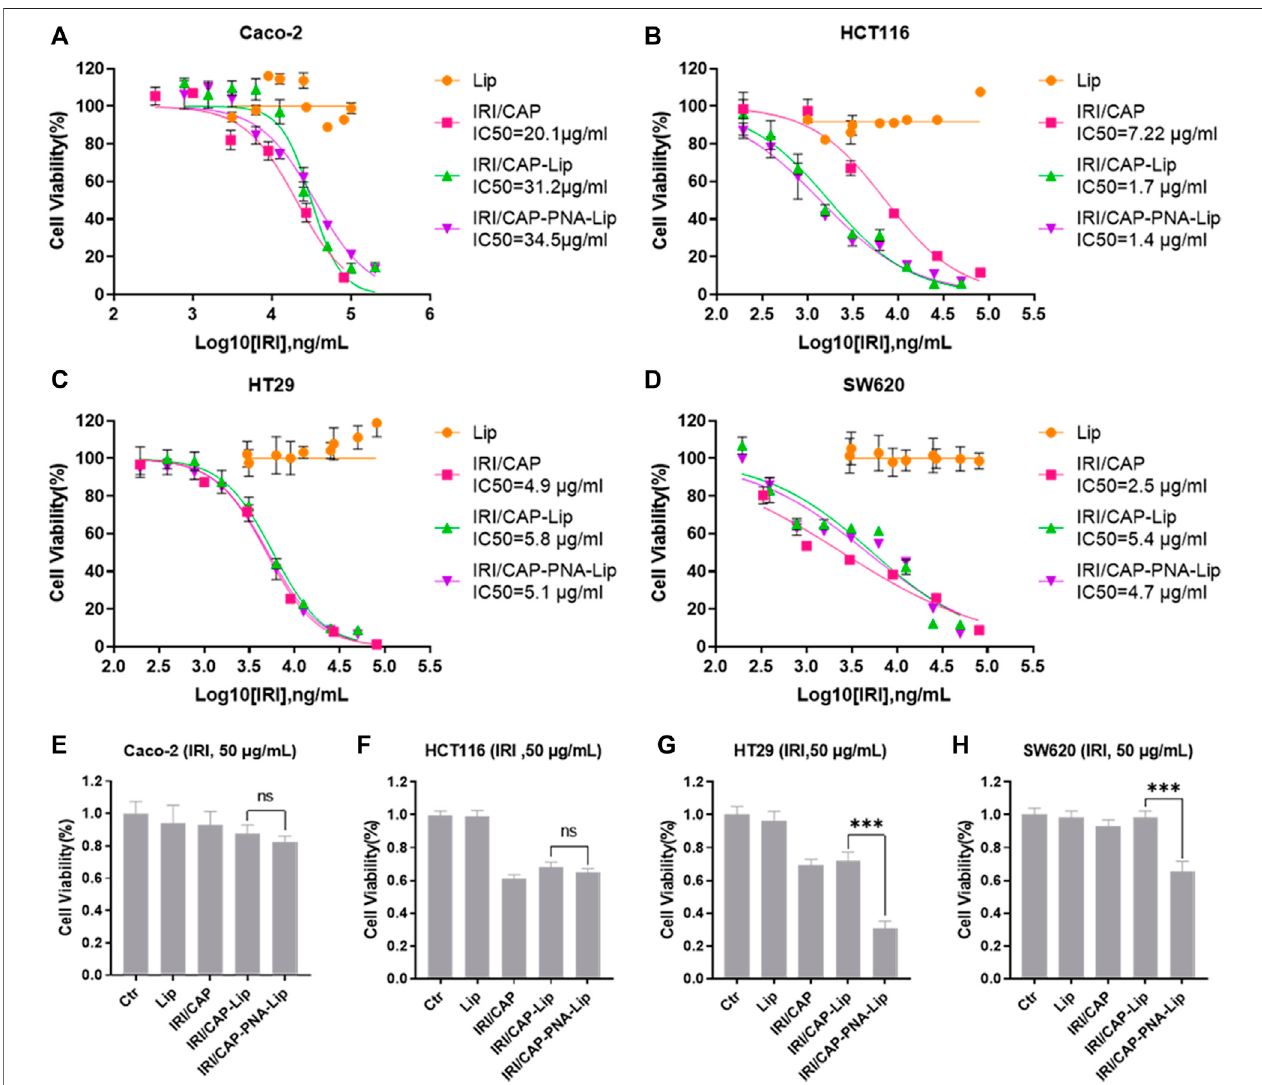
FIGURE 6 | IRI/CAP-PNA-Lips signi fi cantly inhibited the viability of MUC1-positive colorectal cancer cell lines in vitro . (A – D) Cytotoxicity analysis of coloaded liposomes in Caco-2, HCT116, HT29, and SW620 cell lines. (E – H) Effect of an IRI concentration of 50 μ g/ml on cell viability after treatment of Caco-2, HCT116, HT29, and SW620 cell lines for 24 h. The data are presented as the mean ± SD ( n = 3). ***p < 0.001.